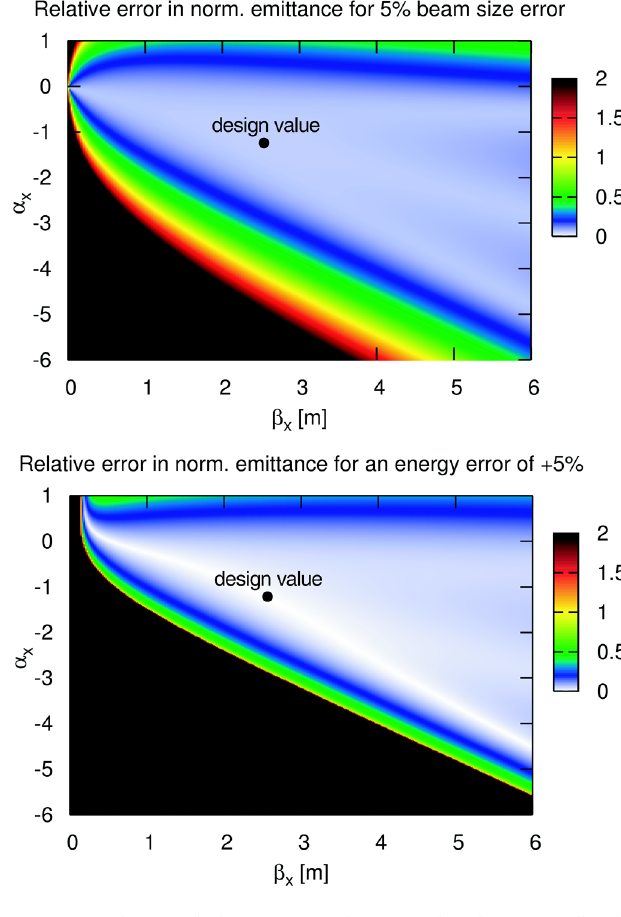
FIG. 3. (Color) Relative systematic error in the normalized horizontal emittance as a function of the Twiss parameters (cid:3) and (cid:4) at the first screen in the FODO lattice for a 5% error in the beam sizes (top) and 5% error in the beam energy (bottom). The color black indicates a relative error in the normalized emittance larger than